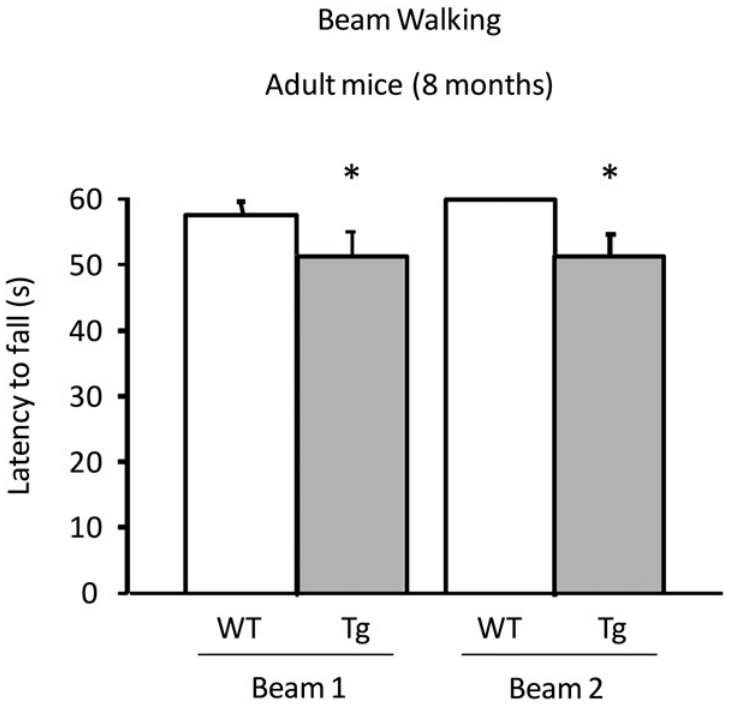
Fig 4. Assessment of motor function using the Beam Walking test. Tg adult mice (8 month-old) showed a lower latency to fall from the beams compared to wild-type. Results are presented as mean + S.E.M. * P <